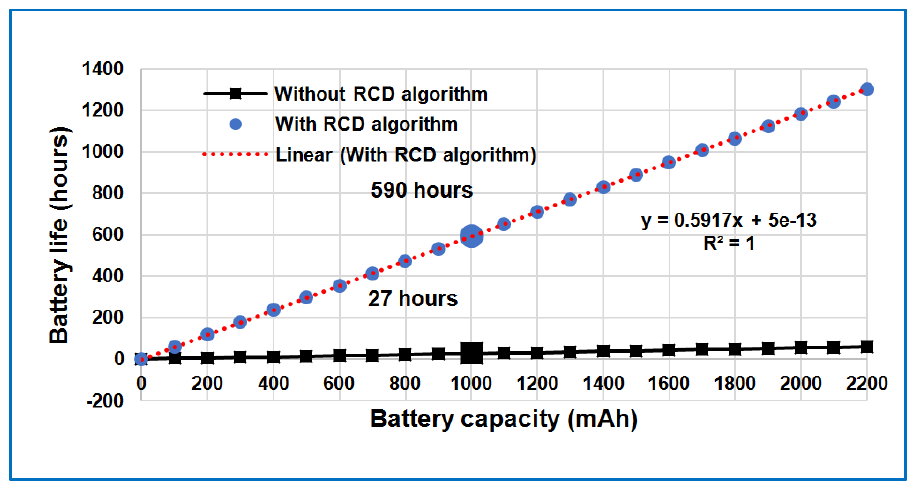
Figure 6. Expected battery life versus usable battery capacity in the sensor